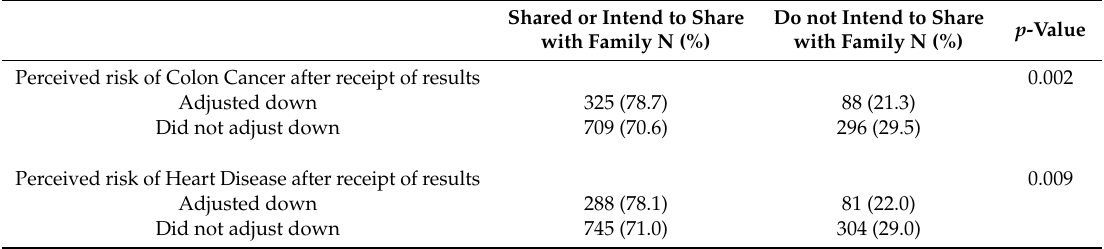
Table 5. Participants who shared or intended to share results with family members, stratified by participants who adjusted risk down after receipt of results and participants who did not adjust risk down after receipt of